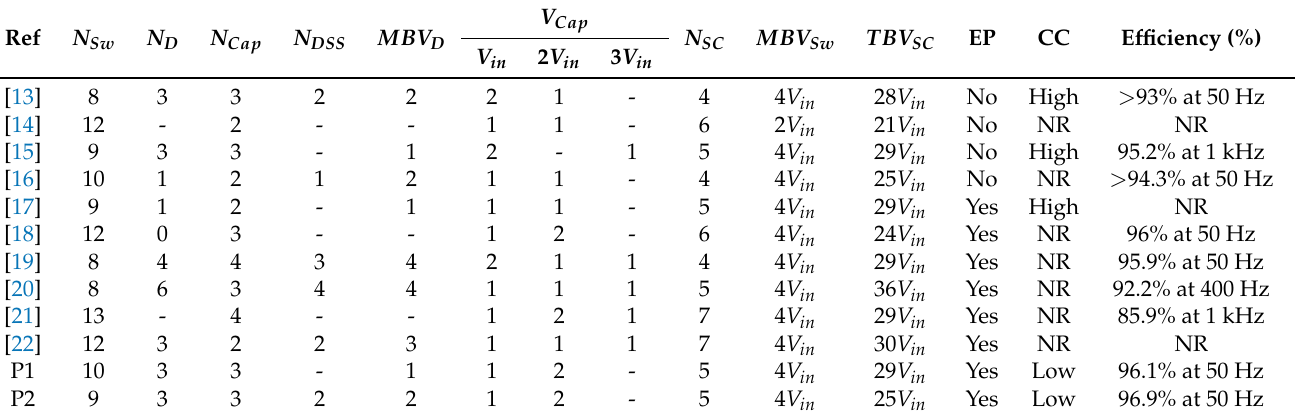
Table 5. State-of-art Single Source Nine Level Inverter Topologies.